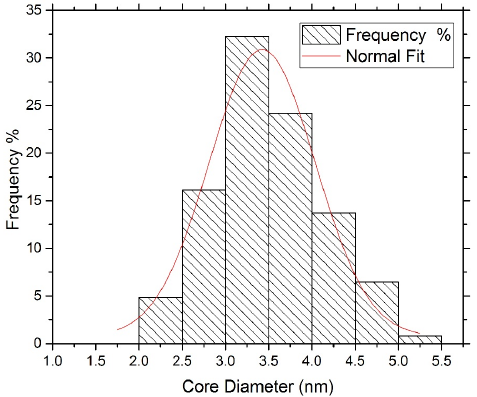
Figure 3. Size distribution histogram of iron core when pure argon is used. Table 2. This table contains the iron core coefficient of variation (CV) for each simple. CEINPs 1